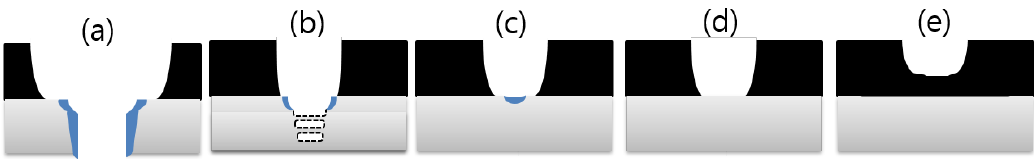
Figure 6. Category of five physical phenomena: ( a ) full penetration with a wider top width of the electrode; ( b ) the partial penetration of current collector; ( c ) the partial melting of the current collector; ( d ) full ablation of active electrode material; ( e ) partial ablation of active electrode material. Error! Reference source not found. shows SEM images with a laser power of 250 W and these show very significant changes in terms of physical phenomena from the full penetration to the partial penetration to the partial melting. With a laser scanning speed of 500 mm/s to 2000 mm/s, full